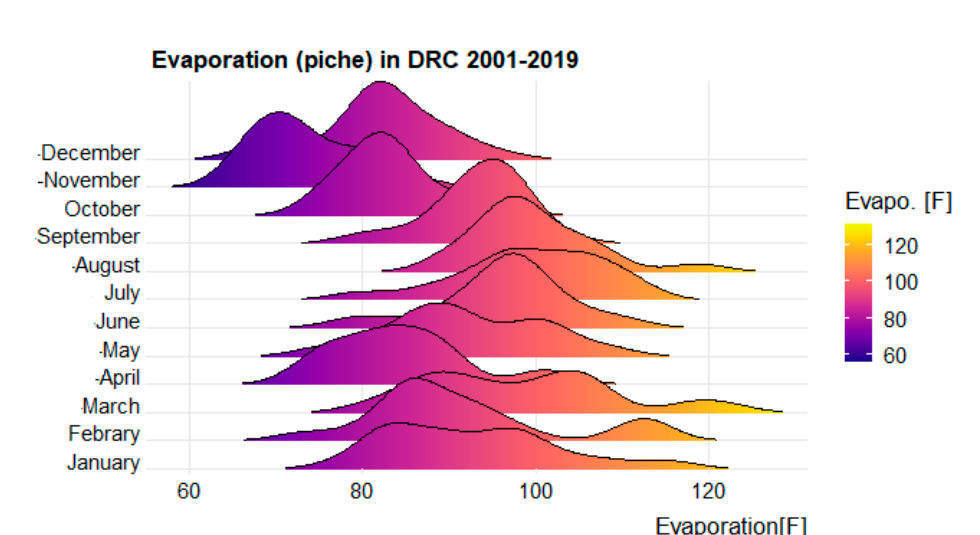
Figure A1. Evaporation (piche) in DRC (2001–2019).